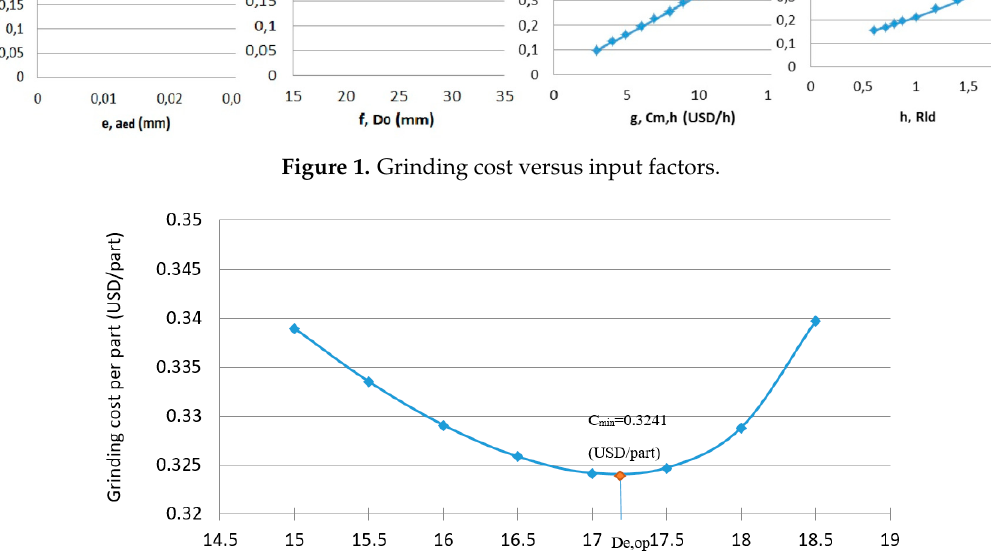
Figure 2. Grinding cost versus replaced wheel diameter.